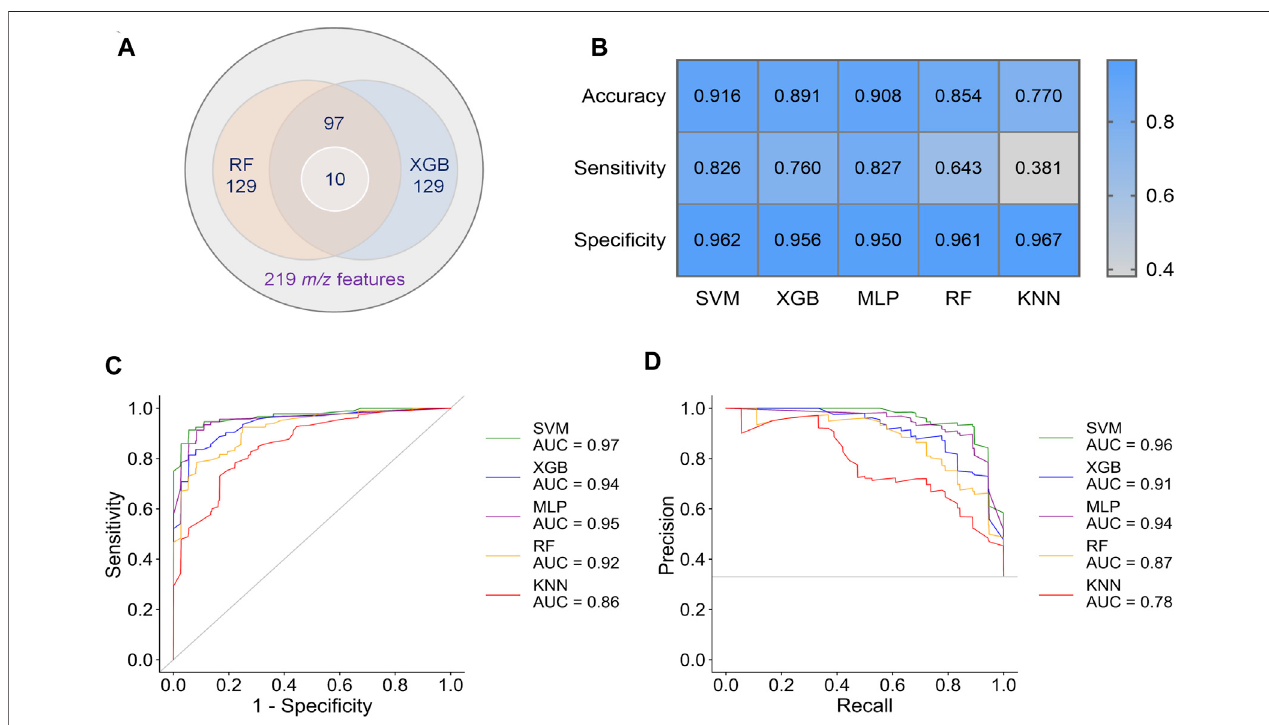
FIGURE3| Resultsofpreliminaryclassi fi cationandmachinelearninganalysiswith97features. (A) Venndiagramofthefeatureselection.97commonfeatureswith high importance in both RF and XGB models were selected from 219 m/z features. Then, 10 of biomarkers were found from these 97 features. (B) Performance indicators of fi ve separate machine learning models. (C) ROC curves of fi ve separate machine learning models. (D) PR curves of fi ve separate machine learning models.